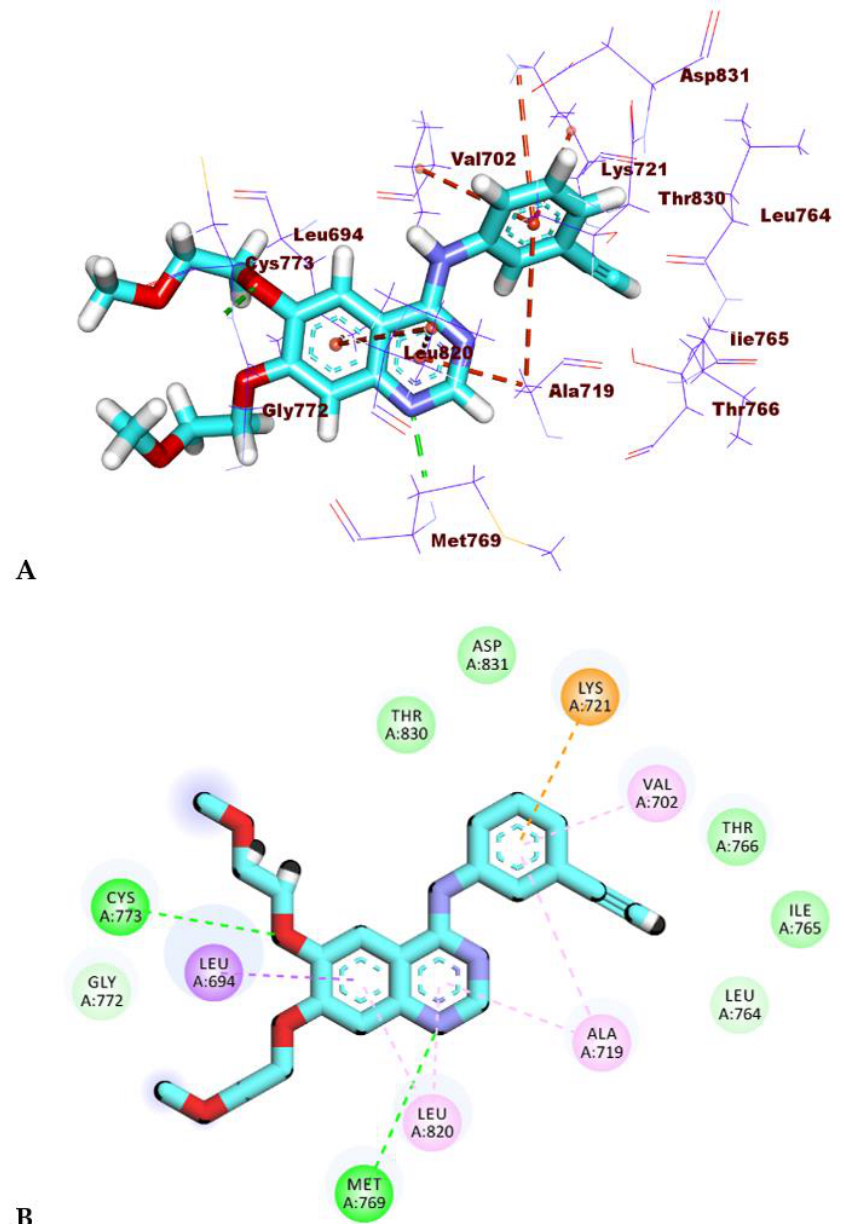
Figure 3. ( A ) 3D and ( B ) 2D interaction pattern of erlotinib in of EGFR WT active site. Similar to how erlotinib binds, T-2-PNPA was able to employ its 6-oxo group of the 1 H -purine moiety to anchor the adenine pocket via a key HBing formation with Met793. Additionally, in the same pocket, the whole nucleus (3,7-dimethyl-2,6-dioxo-2,3,6,7-tetrahydro-1 H -purine moiety) was involved in three hydrophobic bond (HI)s with Leu694 and Cys773. Regarding the hydrophobic pocket, the 4-nitrophenyl moiety was engaged in two pi–pi and two electrostatic interactions with Ala719, Val702, Lys721, and Asp831, respectively. As previously stated, our assumption was that the nitro group would interact with the molecular target via a charge-reinforced HB or electrostatic charge (Figure 4).